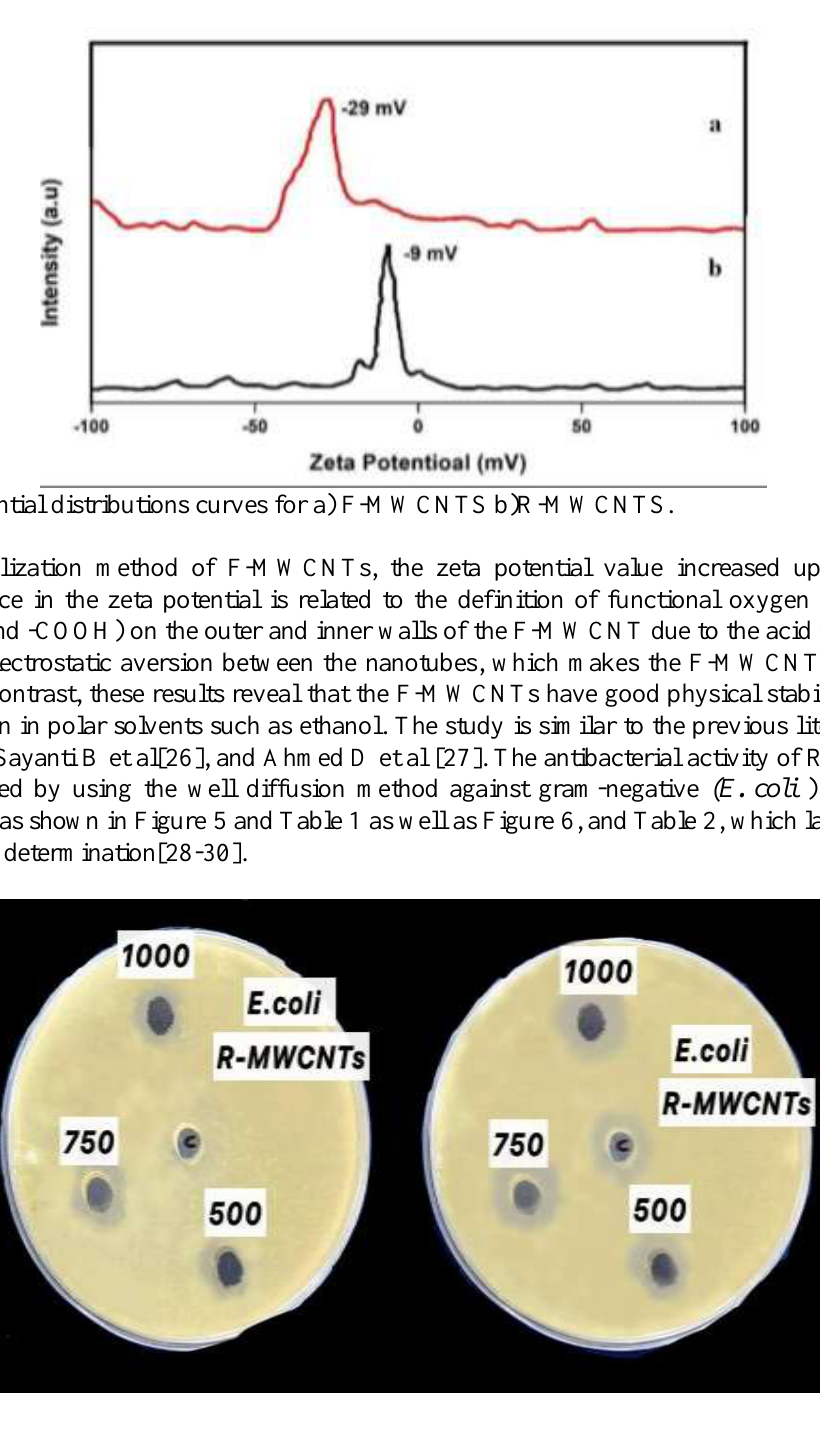
Figure 5: Images of Inhibition Zone diameter (IZ) with different concentrations of antibacterial R-MWCNTs against S. aureus and E . coli and b) the table of (IZ) against S . aureus and E . coli